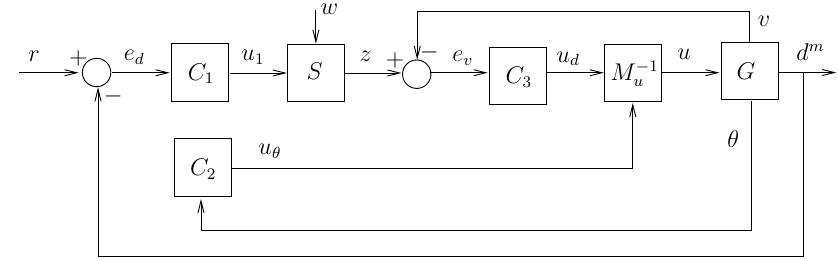
Figure 6. Cooperative control scheme with speed